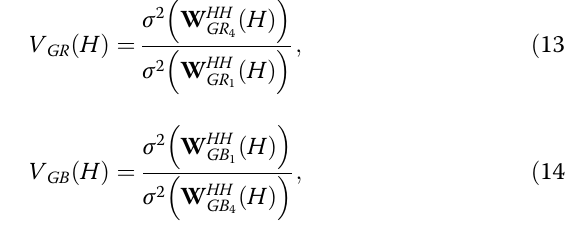
shifted image and estimated as H F = 360 − H . The min test conditions are the same as in Fig. 3. As shown in Fig. 4, the estimation errors obtained by the proposed method are smaller than those obtained by the AIVC algorithm. The average estimation error of the pro- posed method for the eight sample images is 0.25°. The average estimation error of the AIVC algorithm for the eight sample images is 12.75°, as shown in Fig. 3. How- ever, we notice that the minimum value occurs twice at H and H + 180 ° in our method. This is because min min our algorithm is based on the variance of color differ- ence values. The absolute values of color difference have periodicity because blue and red color values are shifted from the green value by 120° and 240°, respect- ively, as shown in Fig. 5. This situation yields conflict- ing results. Because the minimum value occurs twice at H and H + 180 ° , we can trace only half of the total min min angle range to estimate the exact shifted hue angle.